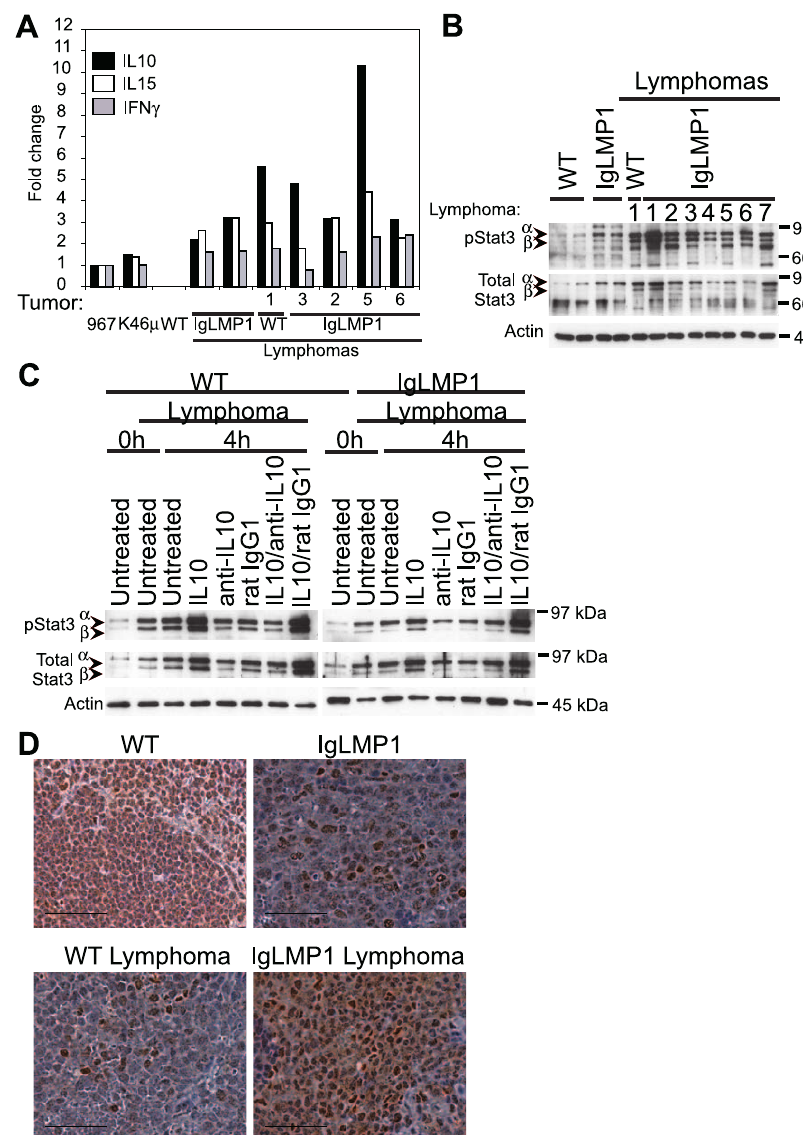
Figure 5. LMP1 Upregulates IL10 Expression and Constitutively Activates Stat3 (A) Relative expression of IL10, IL15, and IFN c mRNA in WT and LMP1 transgenic B cells (CD19 þ ), as detected with an Rnase protection assay. Mouse lymphoma cell lines 967 and K46 l were used as controls. Expression levels were quantified with a phosphorimager and values were normalized to the ribosomal housekeeping gene L32. The cytokine:L32 ratio was set to 1 in the mouse B cell lymphoma line 967. (B and C) Immunoblot analysis of activated pStat3 in purified B cells (CD19 þ ) from WT and LMP1 transgenic mice (B) at the time of harvest, and (C) 4 h after culture with or without IL10, a neutralizing antibody to IL10, or a rat IgG1 isotype control. (C) Shown are the results for WT lymphoma 1 and LMP1 transgenic lymphoma 1. Arrows indicate the positions of the a and b isoforms of Stat3. Actin was used as a loading control. (D) Immunohistochemistry detection of activated nuclear pStat3 in the spleens of WT and LMP1 transgenic mice. Scale bar, 20 l m.